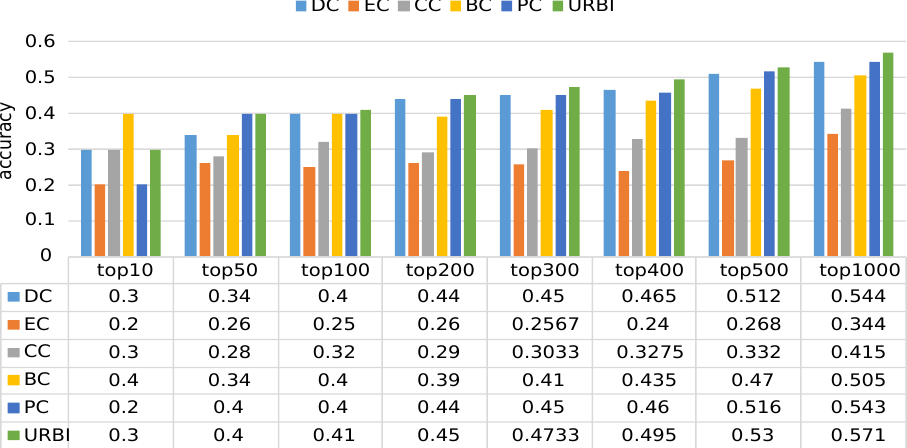
Figure 10. This figure depicts the experimental results of dataset No.10, which contains 8495 book nodes.